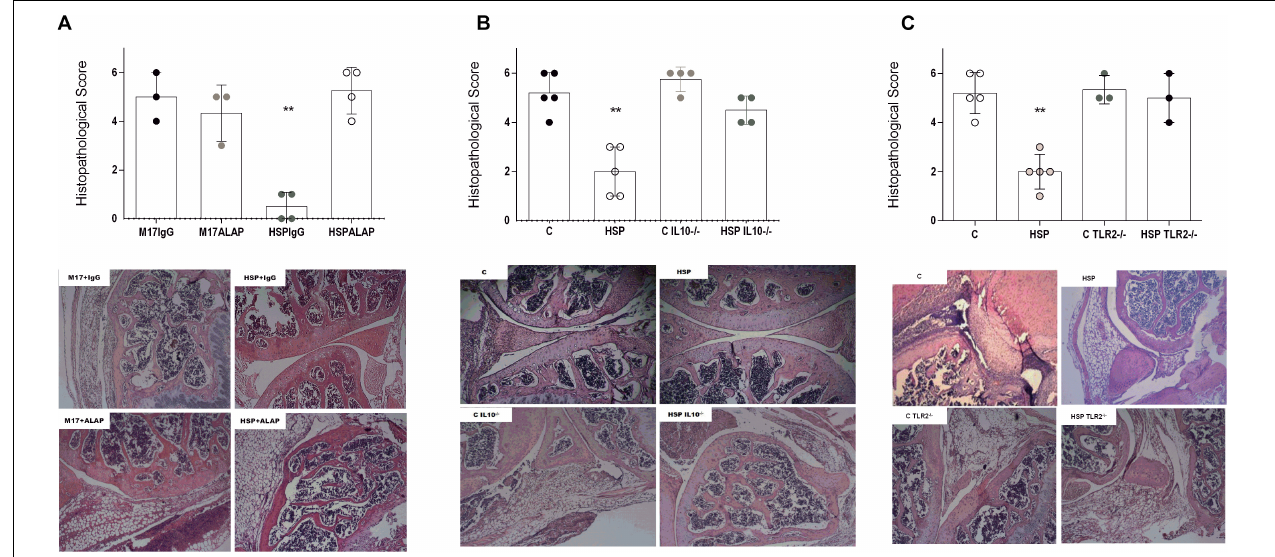
FIGURE 6 | Regulatory components involved in the effect mediated by Hsp65-producing L. lactis. BALB/c mice fed Hsp65-lac for four consecutive days were previously injected with Anti-LAP antibody (HSP+ALAP) or IgG4 (HSP+IgG) intermittently for four days. Ten days after treatment arthritis was induced with four injections of OVA+CII in CFA. At day 95 all animals were euthanized, and the right knees were used for preparation of histological sections stained with HE. IL10 −\− 129 Sv/Ev and TLR2 −\− C57BL/6 were treated with either XM17 broth (C IL10 −\− and C TLR2 −\− ) or Hsp65-lac (HSP IL10 −\− and HSP TLR2 −\− ). Wild type (WT) mice were used as control for both experiments using the mBSA-induced acute model of arthritis. Histopathological score and HE stained section of (A) mice treated with anti-LAP antibody. (B) Deficient for IL-10 and (C) TLR2. Bars represent the score based on inflammatory infiltrate, pannus, cartilage and bone erosion. Values represent the mean ± SEM. * p < 0.05 compared to control C group. ** p < 0.005 compared to control C group. *** p < 0.0005.